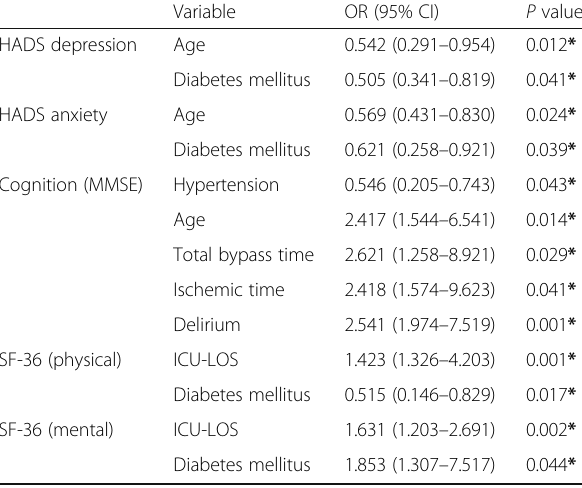
Table 3 Stepwise linear regression analysis for significant variables affecting final outcomes